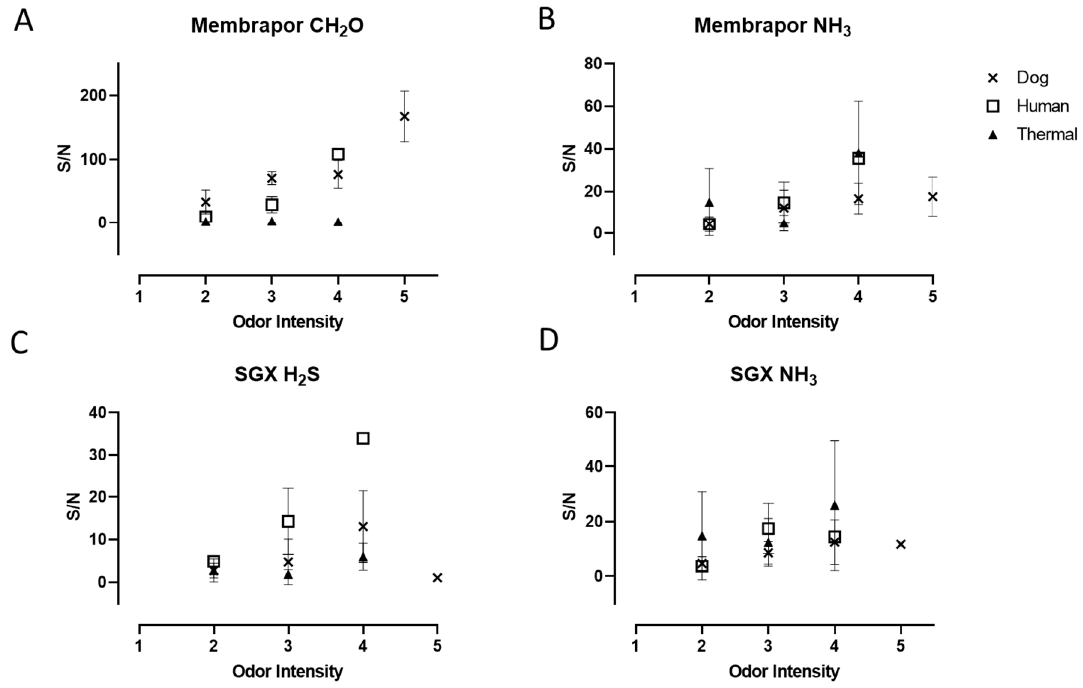
Figure 6. S/N ratios for three malodors specimen by four sensors (same as Figure 5) as a function of the odor intensity. Error bars represent the standard deviation.